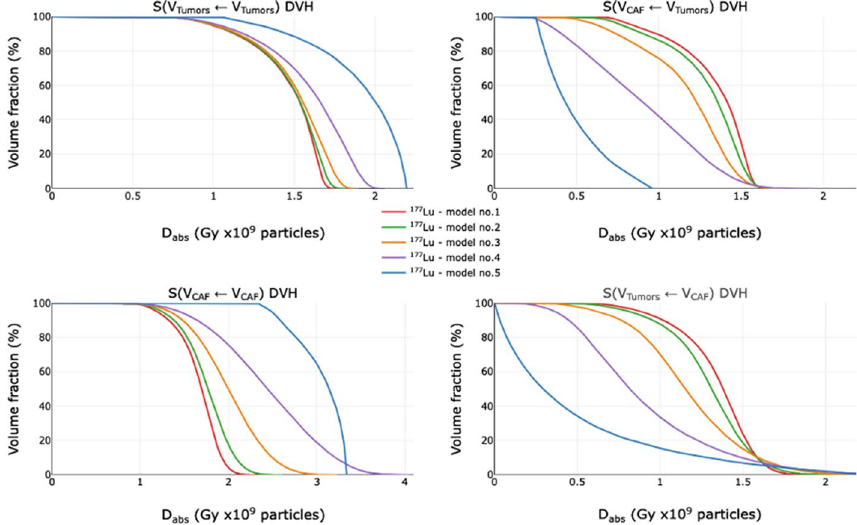
Fig. 6 177 Lu Dose Volume Histograms of the five models for S(v Tumors S(v Tumors v CAF ) and S(v CAF ←